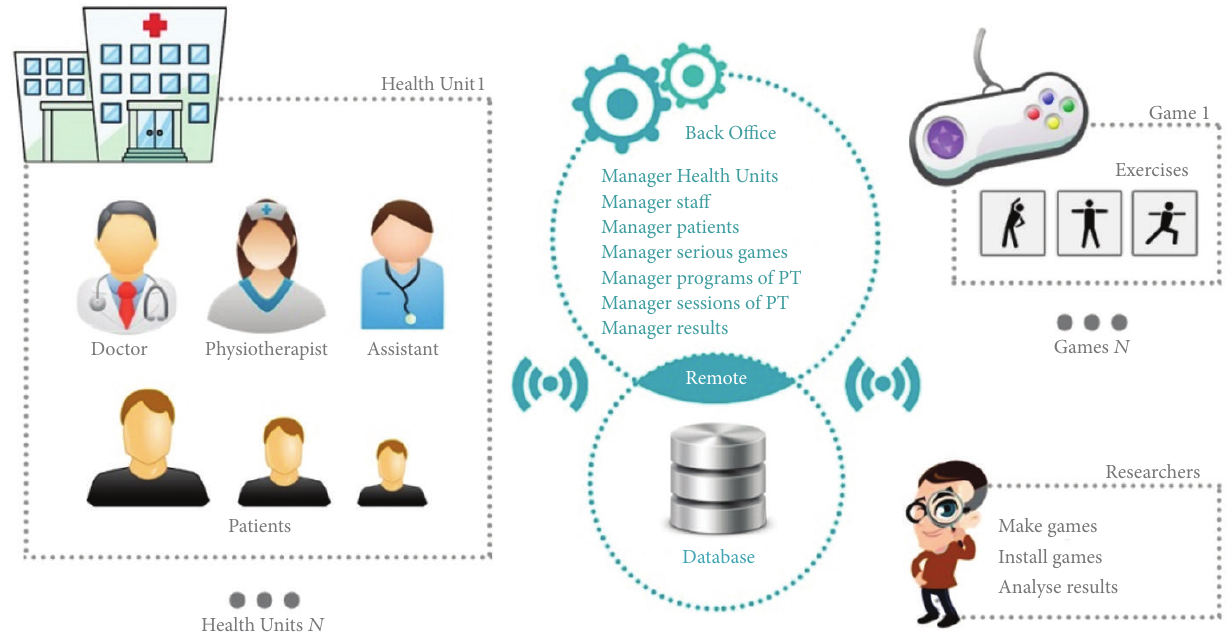
Figure 1: System generic